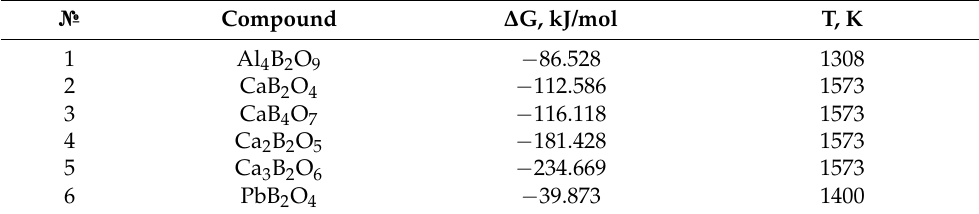
Table 6. Gibbs energy calculated for chemical reactions in a congruent LN melt with a B 2 O 3 flux.